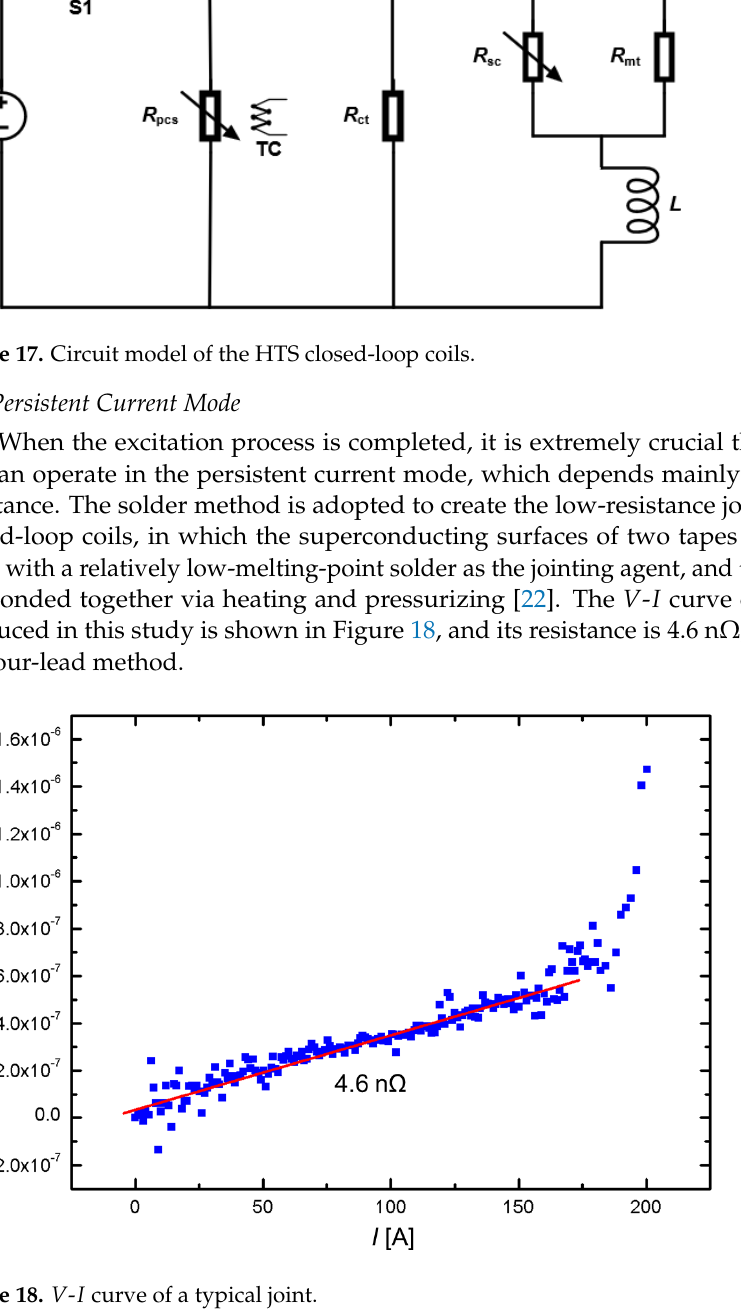
Figure 18. V - I curve of a typical